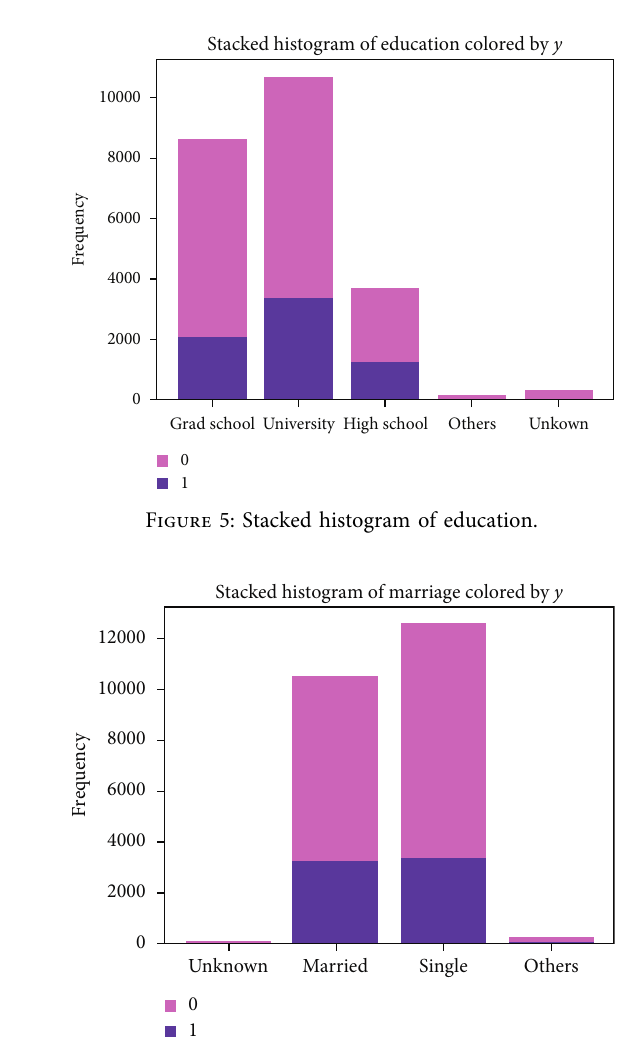
Figure 6: Stacked histogram of